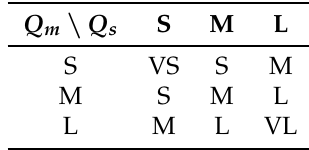
Table 1. Fuzzy rules for inference